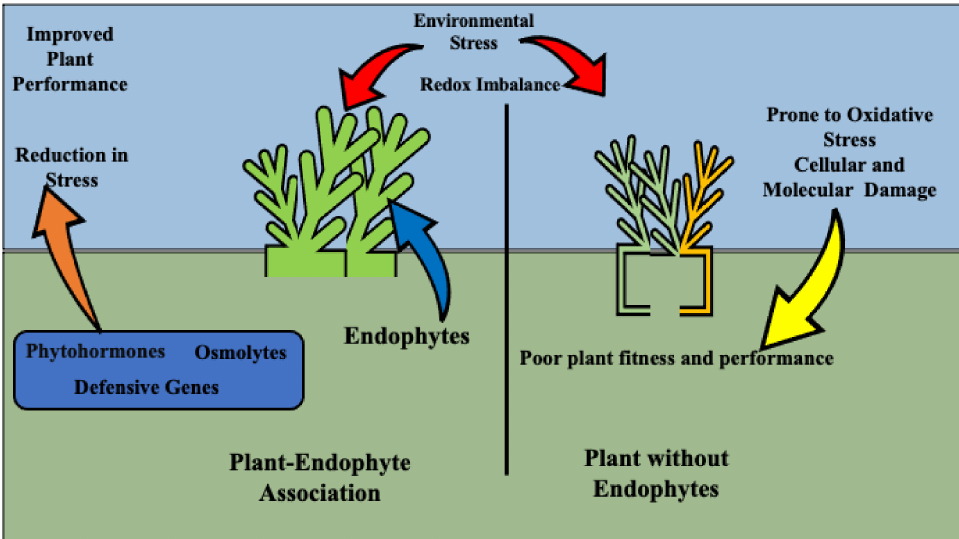
Figure 2. Environmental stressors impact on endophyte-infected and non-infected plants. Stress causes redox imbalances that lead to oxidative damage. In endophyte-free plants, there is little to mitigate this damage. Endophytes upregulate defensive genes and produce osmolytes and phytohormones that are protective against many stressors and reduce the damage done by redox imbalances. This improves the overall plant performance. Arrows represent effects on the plant and